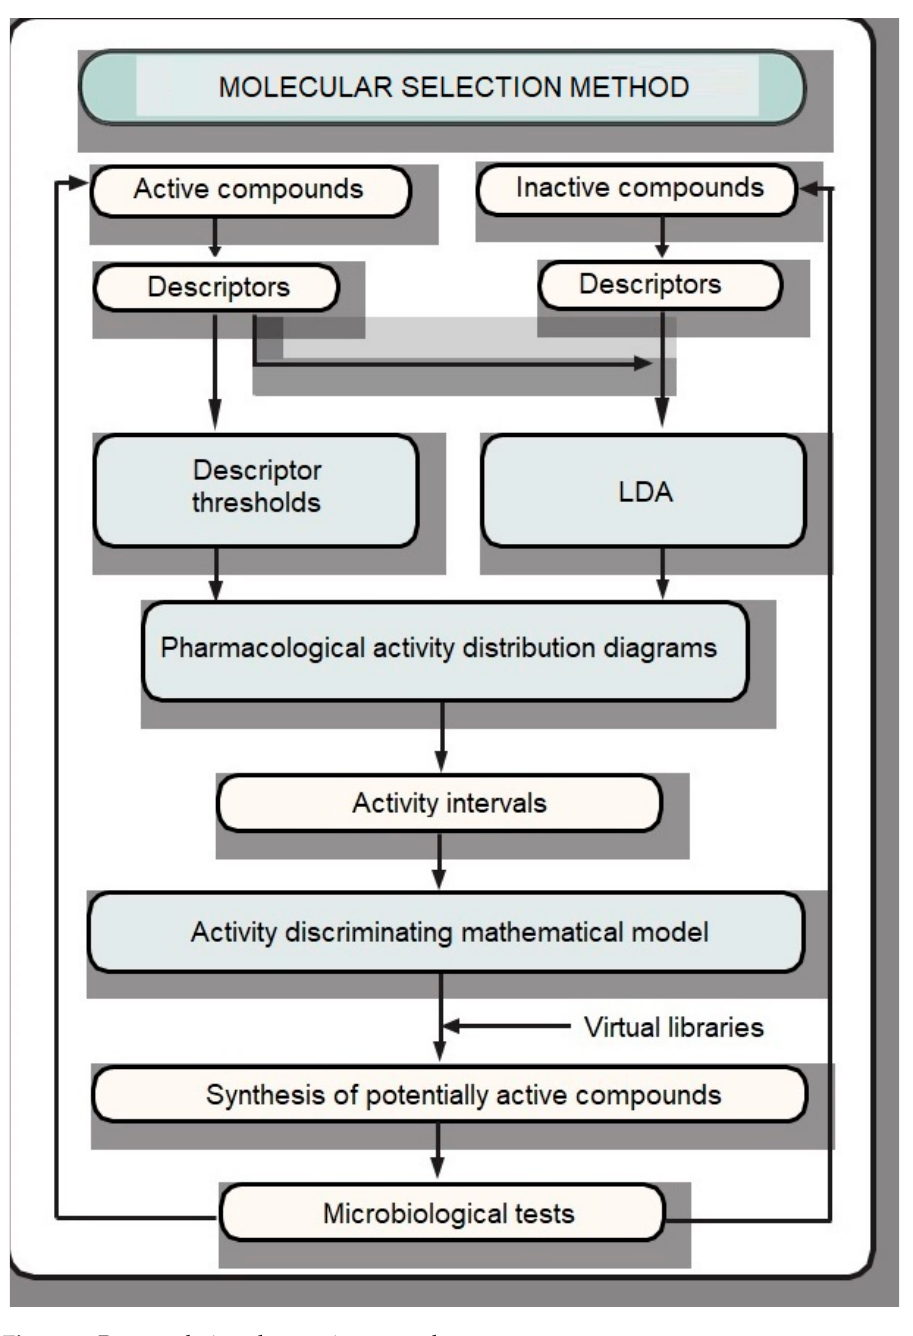
Figure 1. Proposed virtual screening procedure.